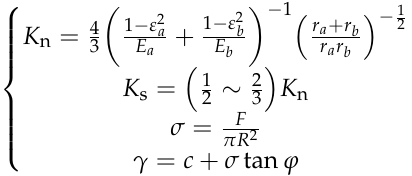
Table 1. Corn straw bonding parameters.